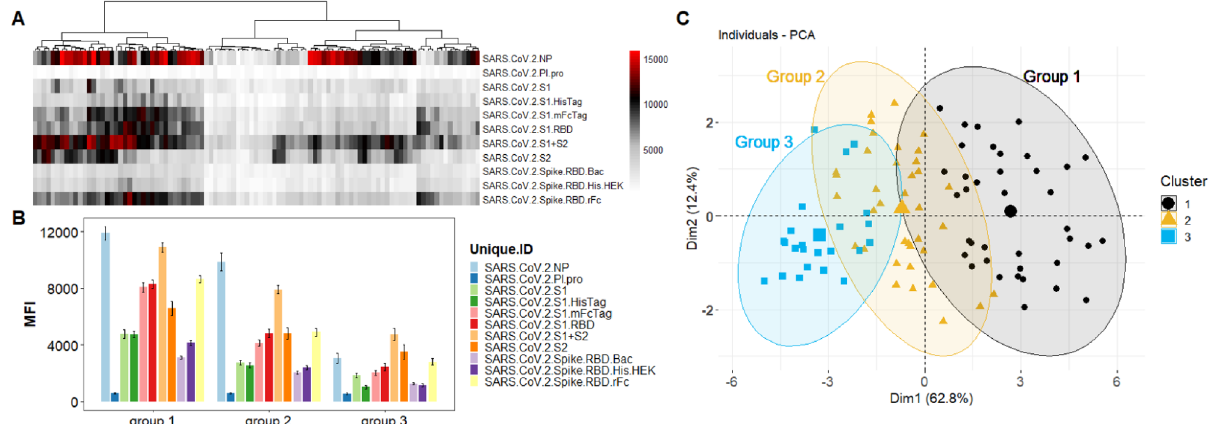
Figure 3. Clustering analysis of the IgG reactivity to the COVAM SARS-CoV-2 antigens. On ( A ), heatmap showing the reactivity to the SARS-CoV-2 antigens. Samples were clustered using the hierarchical Clustering analysis. The dendrogram was cut (and color coded) to a final cluster number equal 3. On ( B ), a bar graph showing the mean reactivity and the standard error of each cluster to each individual SARS-CoV-2 antigen. On ( C ), principle component analysis (PCA) showing the spatial distribution of the samples for the first and second principal components that explain, combined, over 74% of the variance. This figure was generated using the R programing language, version 4.0.2 (https:// www.r- proje ct. org/).